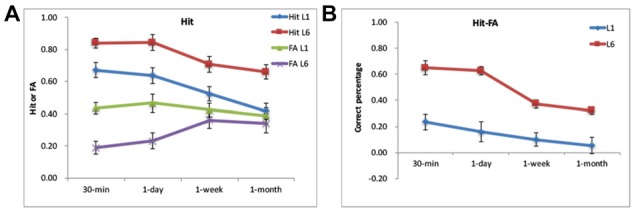
Behavorial results. (A) The Hit and false alarm (FA) rates for the L1 and L6 groups. (B) The Hit-FA performance for the L1 and L6 groups.